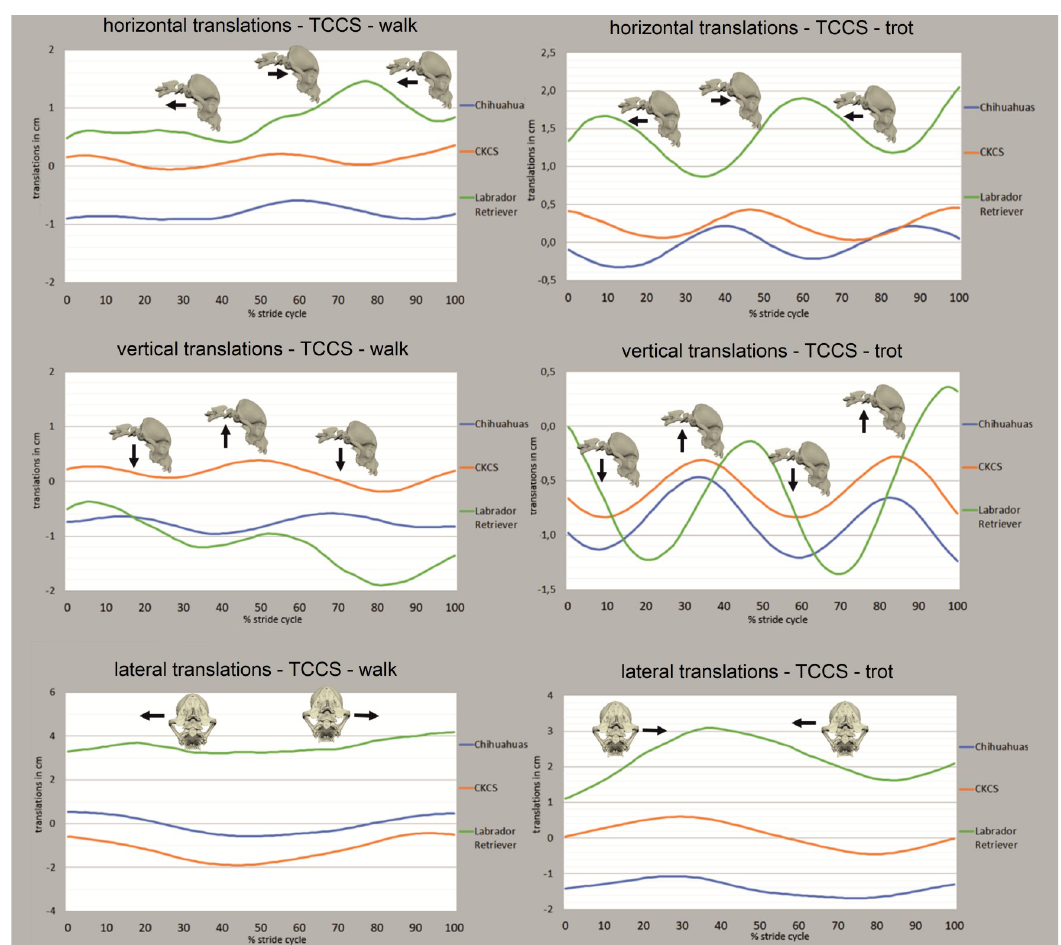
Fig 5. Phase-normalised translational movements of the total cranial cervical spine (TCCS) in walk and trot. All translational degrees of freedom as mean values for all strides of Chihuahuas (blue), CKCSs (orange) and Labrador retrievers (green) are depicted. X-axis represents one complete stride cycle from touchdown (0%) to subsequent touchdown (100%) of the left hind limb. Y-axis represents the motion amplitude in cm. Bone models and arrows indicate direction of stride cycle-dependent bone